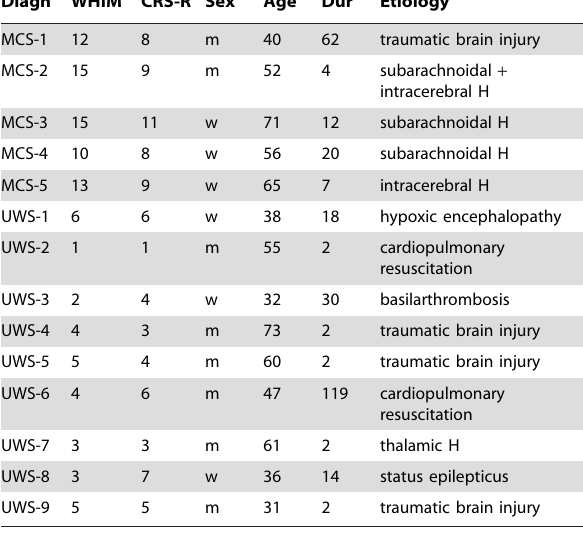
Table 5. Summary of